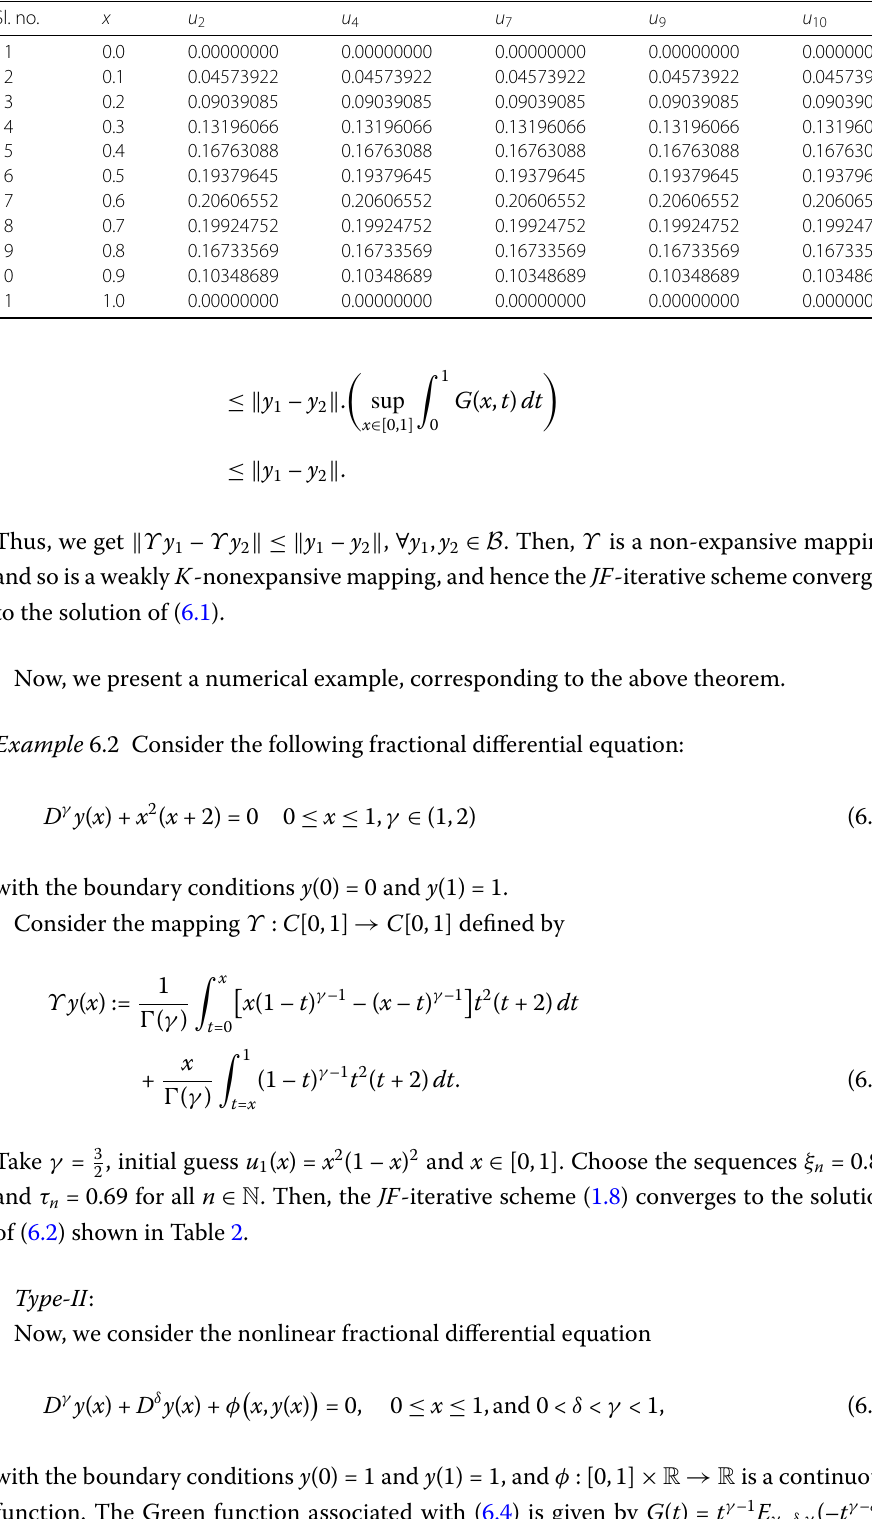
Table 2 Approximate solution of Example